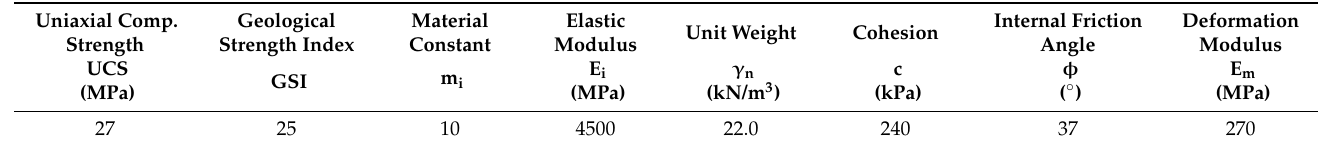
Table 1. Rock mass parameters of the graphitic schists